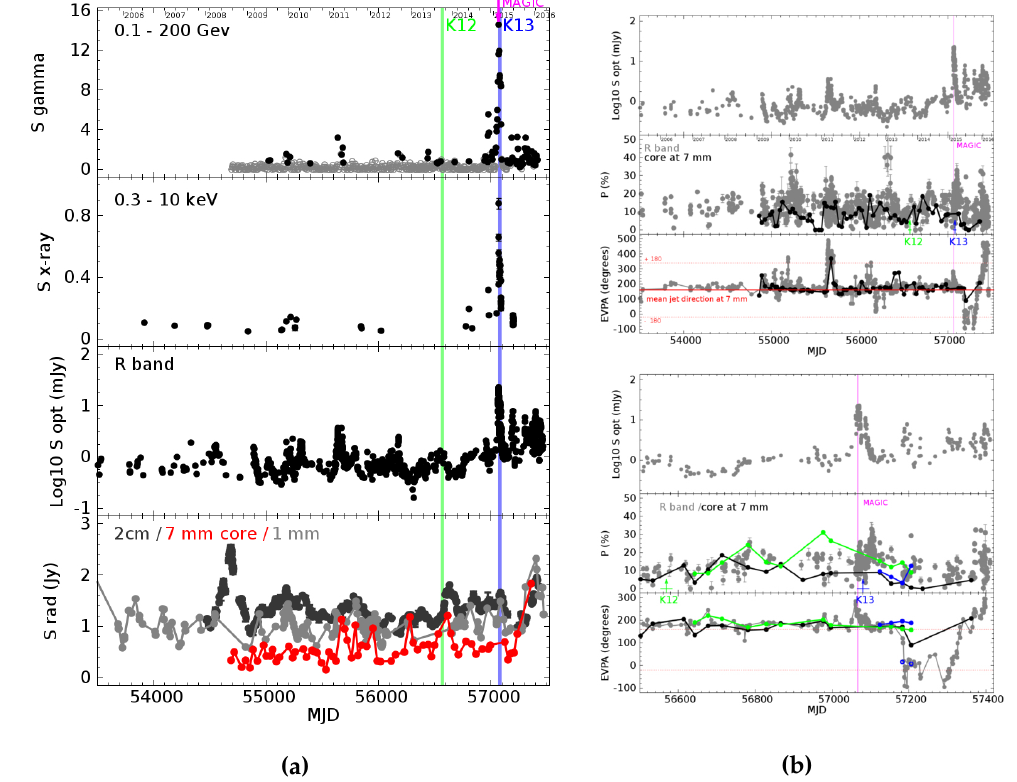
Figure 1. ( a ) Light curves of S4 0954+658 from 2005 to 2016 (from top to bottom): γ -ray, X-ray, R-band optical, and radio (1 mm, 7 mm, and 2 cm). The ejections of new superluminal knots are marked with green bands. ( b ) Upper panel shows R-band optical light curve, fractional polarization, and EVPA. Gray dots show measurements in the R band, black dots are those of the VLBI-core at 43 GHz. Lower panel shows an enlargement of the light curve during the ejections of knots K12 and K13. Green and blue dots correspond to knots K12 and K13,